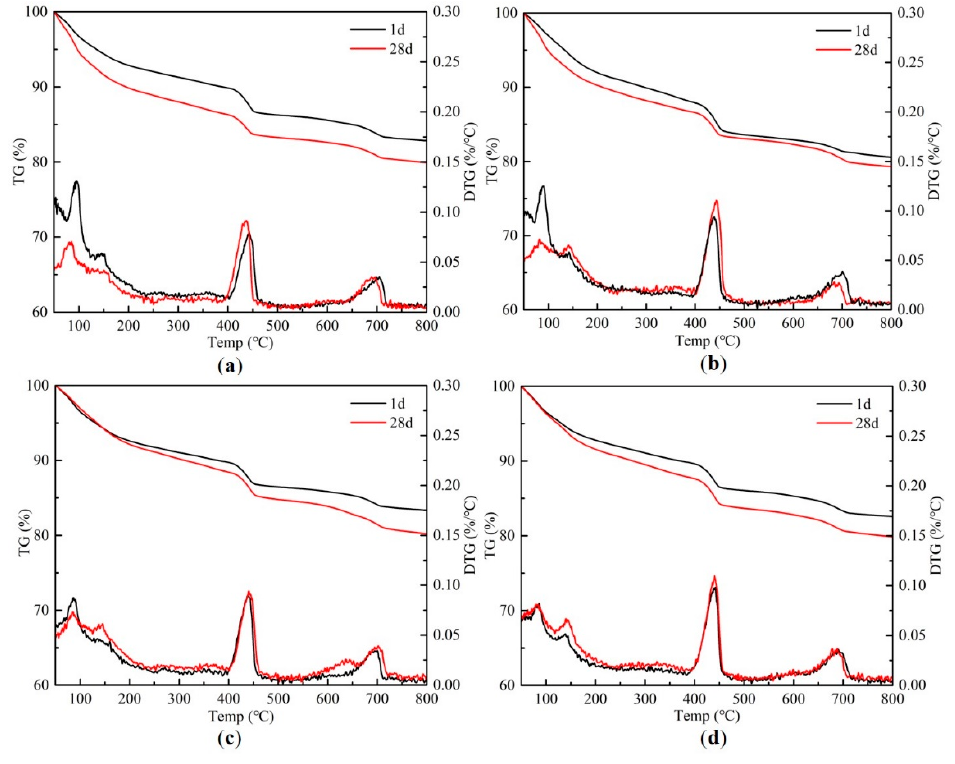
Figure 8. TG results of ( a ) OPC (P), ( b ) m-TiO 2 (P), ( c ) n-TiO 2 (P), and ( d ) TNT (P).